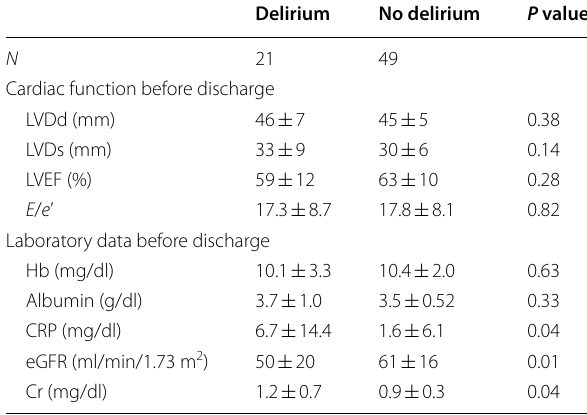
Table 1 Preoperative and perioperative data in each group